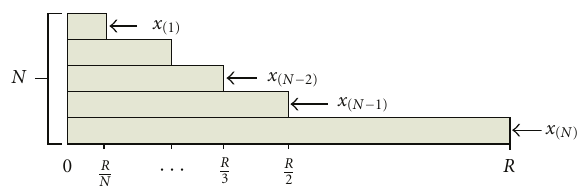
Figure 13: Virtual representation of event A. Random variables ... , x x M are sorted in ascending order in sequence 1 , According to the definition of event A the v th variable must assume a value less or equal R/ ( M − v +